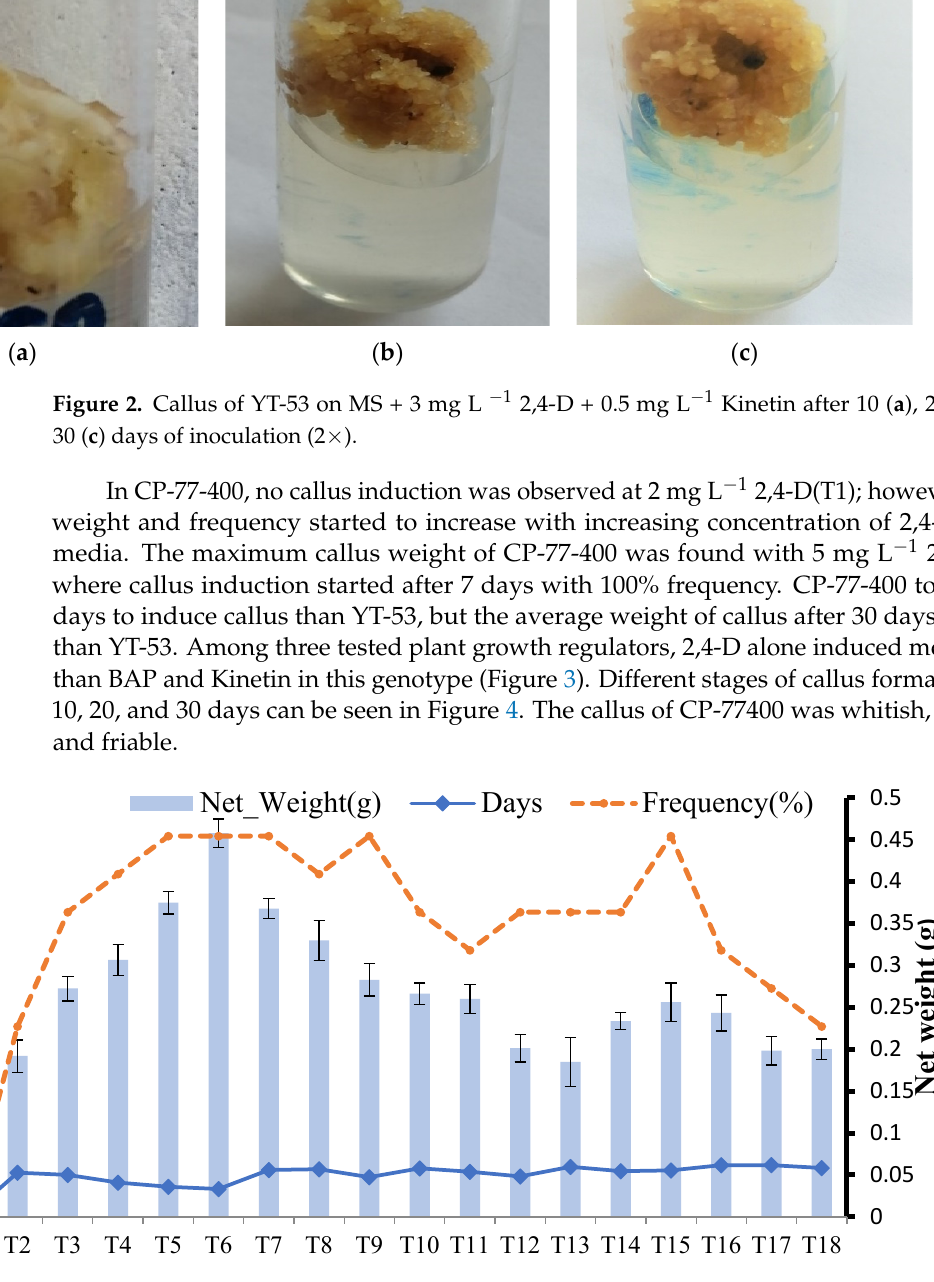
Figure 3. Effect of different media compositions on callus induction in terms of callus, number of days, and frequency in CP-774-00.